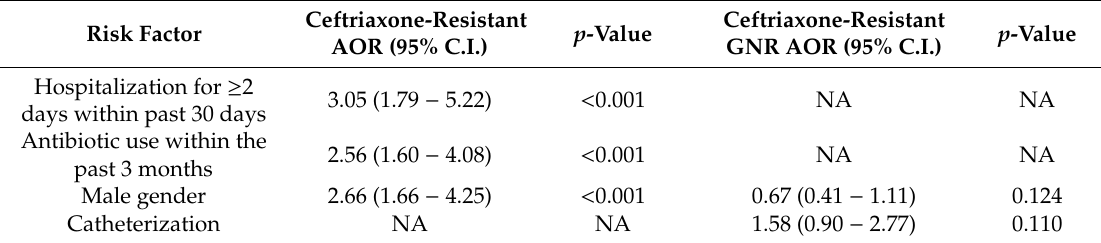
Table 3. Analysis of the presence of ceftriaxone-resistant uropathogens and ceftriaxone-resistant Gram-negative uropathogens (GNR) with multilevel generalized structural equation modeling. Risk Factor